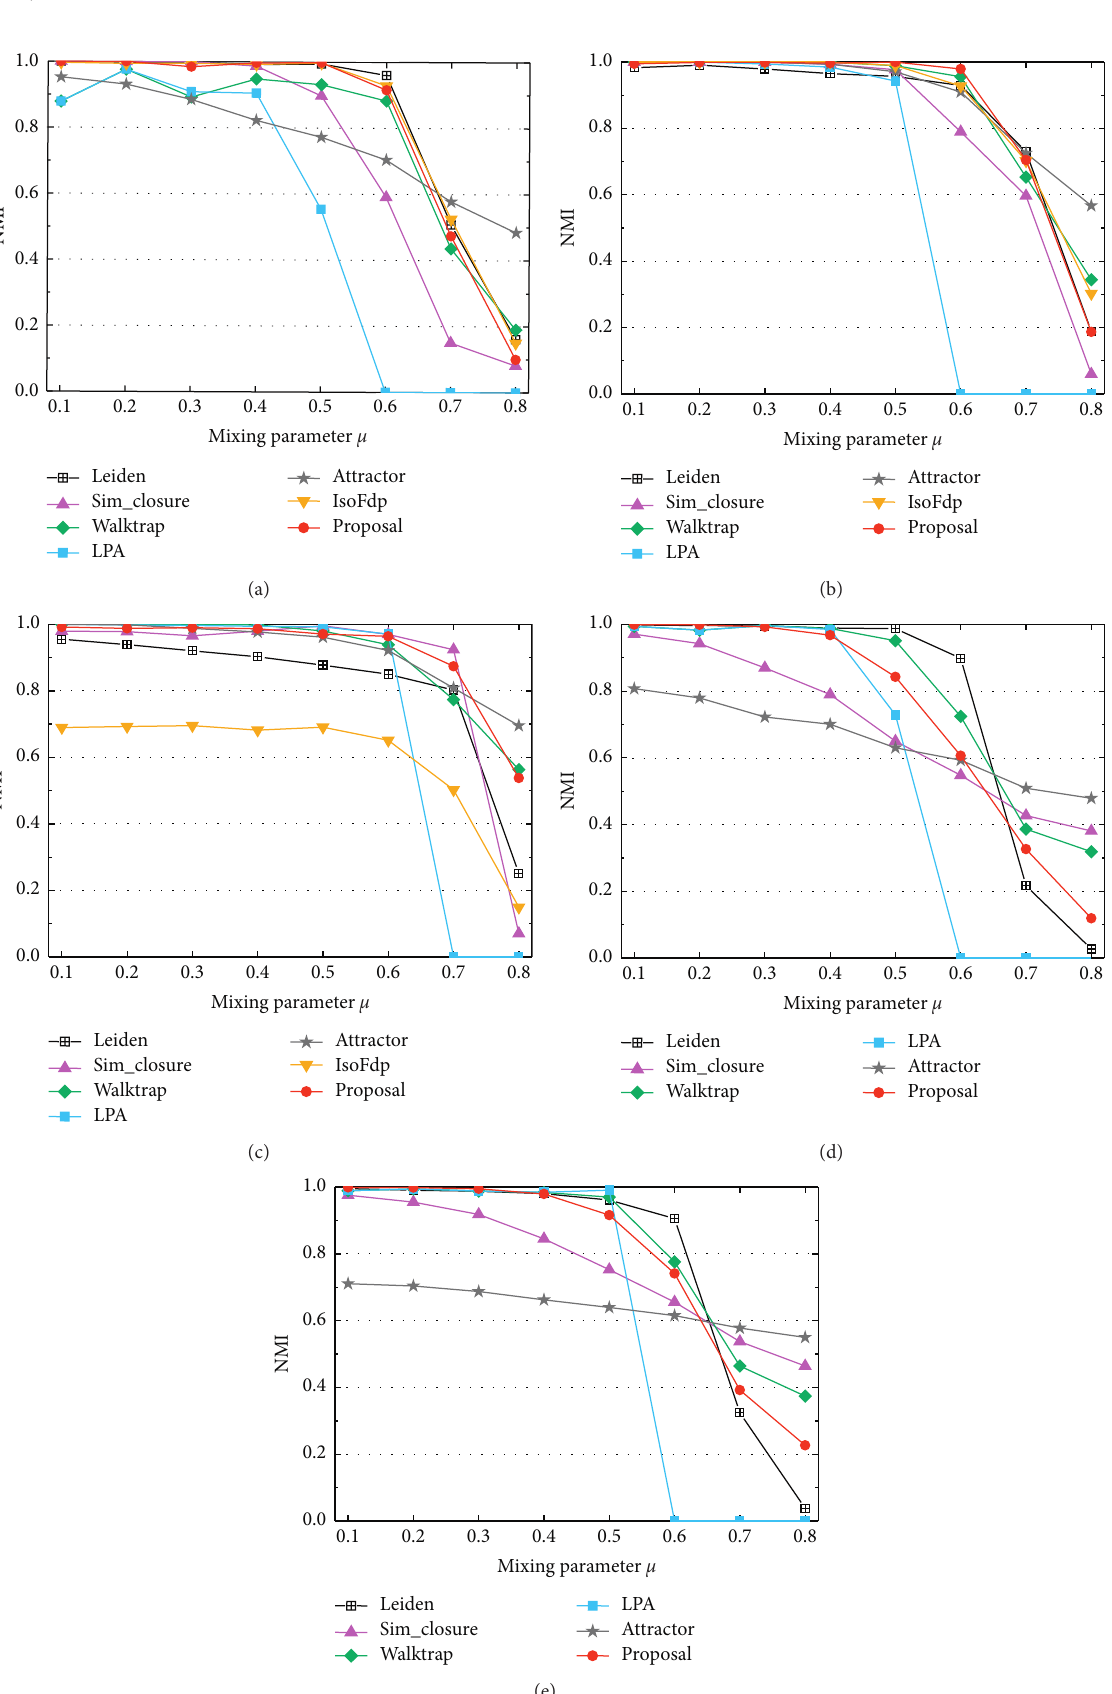
Figure 3: The NMI extracted from the artificial networks. (a) LFR500. (b) LFR1000. (c) LFR5000. (d) LFR10000. (e)